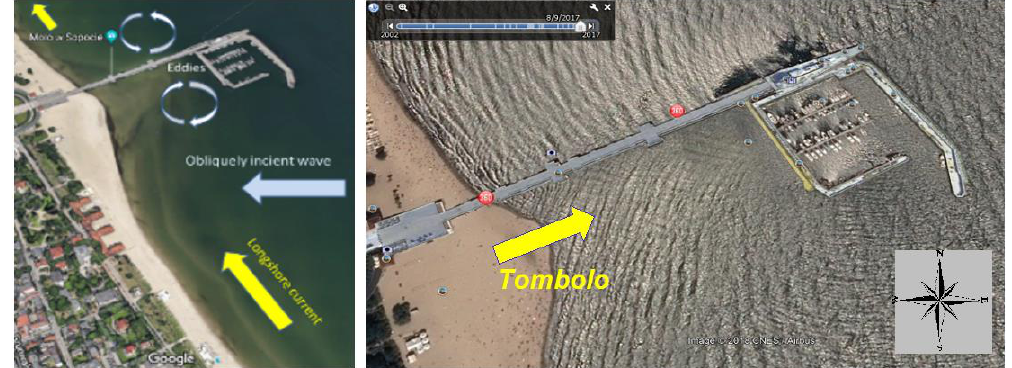
Figure 1. The nature of the phenomenon that causes the formation of the tombolo effect (on the left ), and the wavy surface of the sea in varying directions resulting from the diffraction of waves of the marina breakwater in Sopot (on the right ). Sensors 2020 , 20 , 1167